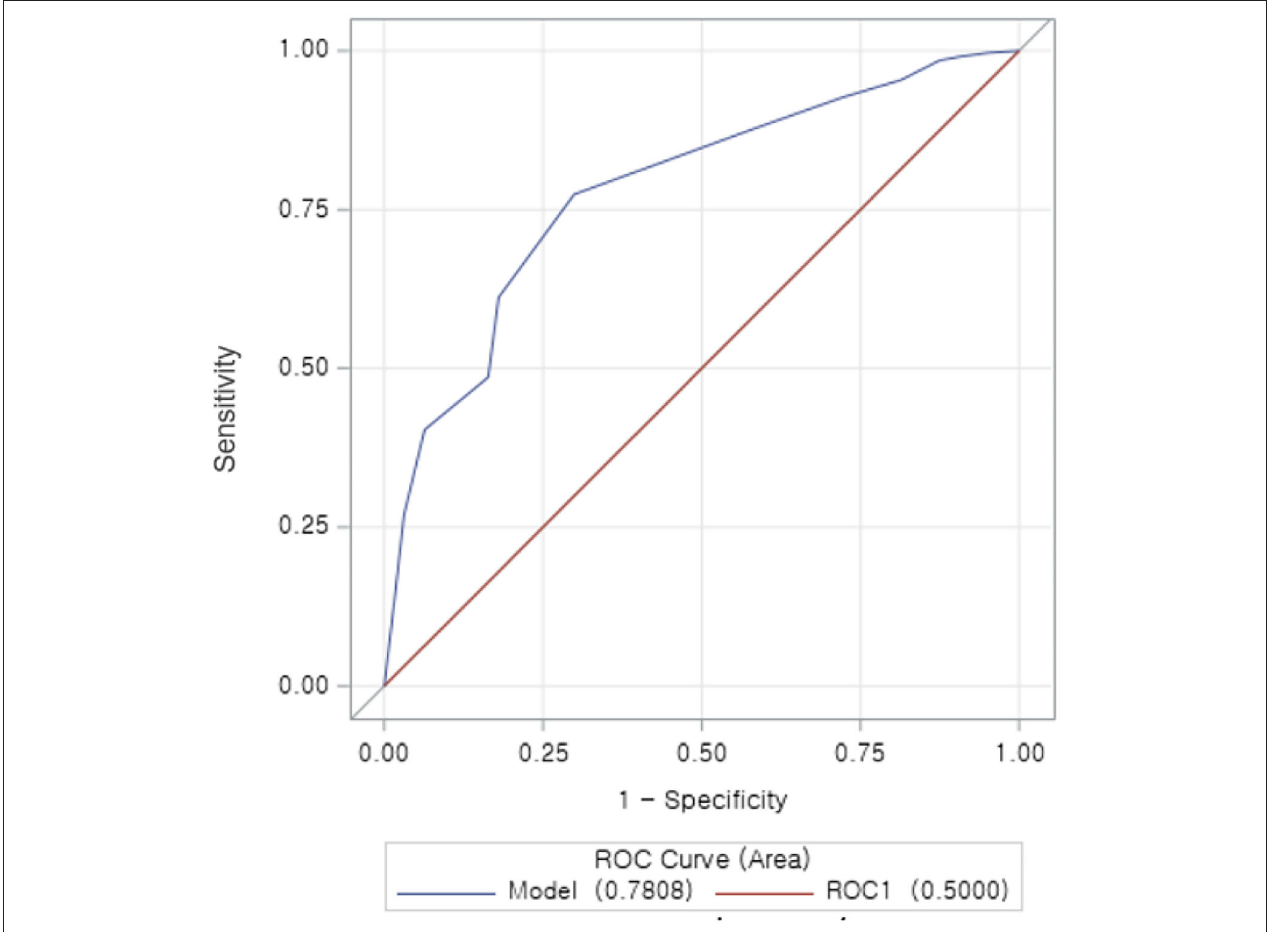
FIGURE 2 | Receiver operator characteristic (ROC) curve for the LACE index in hospitalized AMI patients. The ROC curve illustrates the risk prediction for 30-day readmission at different cutoff points. With increased sensitivity and decreased specificity. The area under the curve (AUC), which is equal to the C -statistic (0.78), indicating a favorable model to predict the risk of 30 days readmission in patients hospitalized with